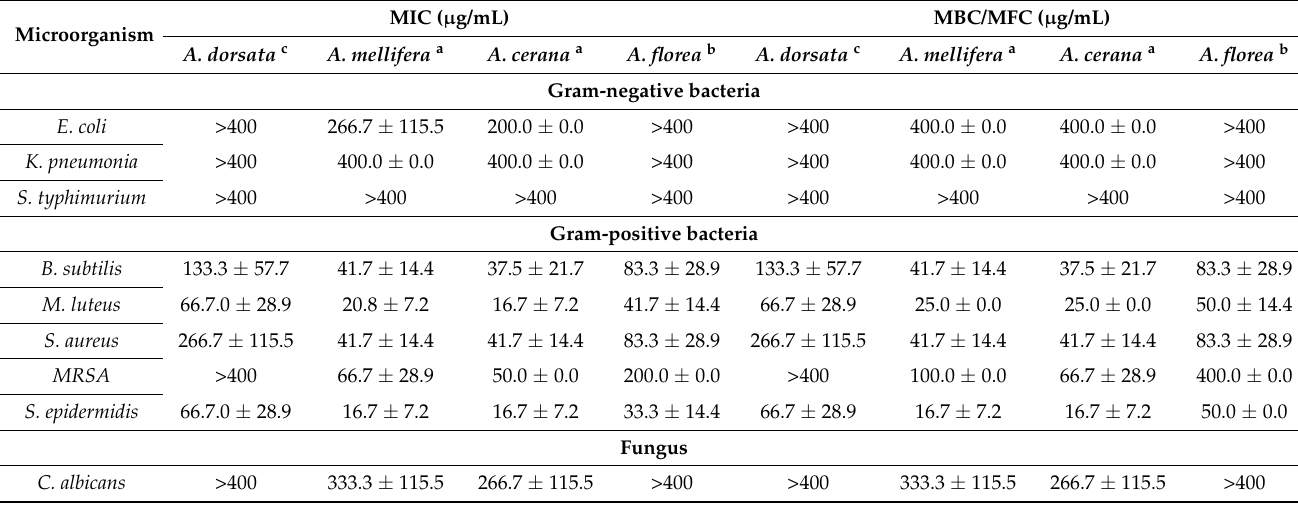
Table 4. Minimum inhibitory concentrations (MICs) and minimum bactericidal concentrations (MBCs) of crude honey bee venom from four honey bee species against pathogenic bacteria. MIC ( µ Microorganism